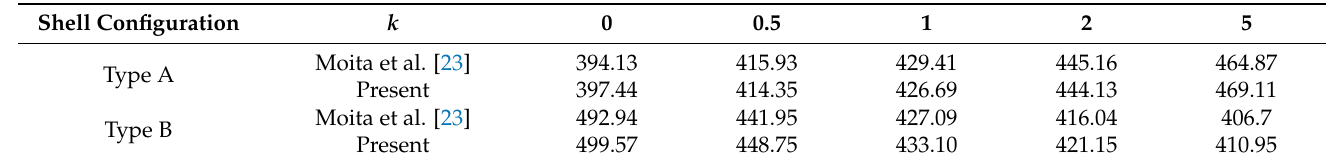
Table 2. Variation of critical buckling temperatures (in K) of FGM cylindrical shells for different material composition.